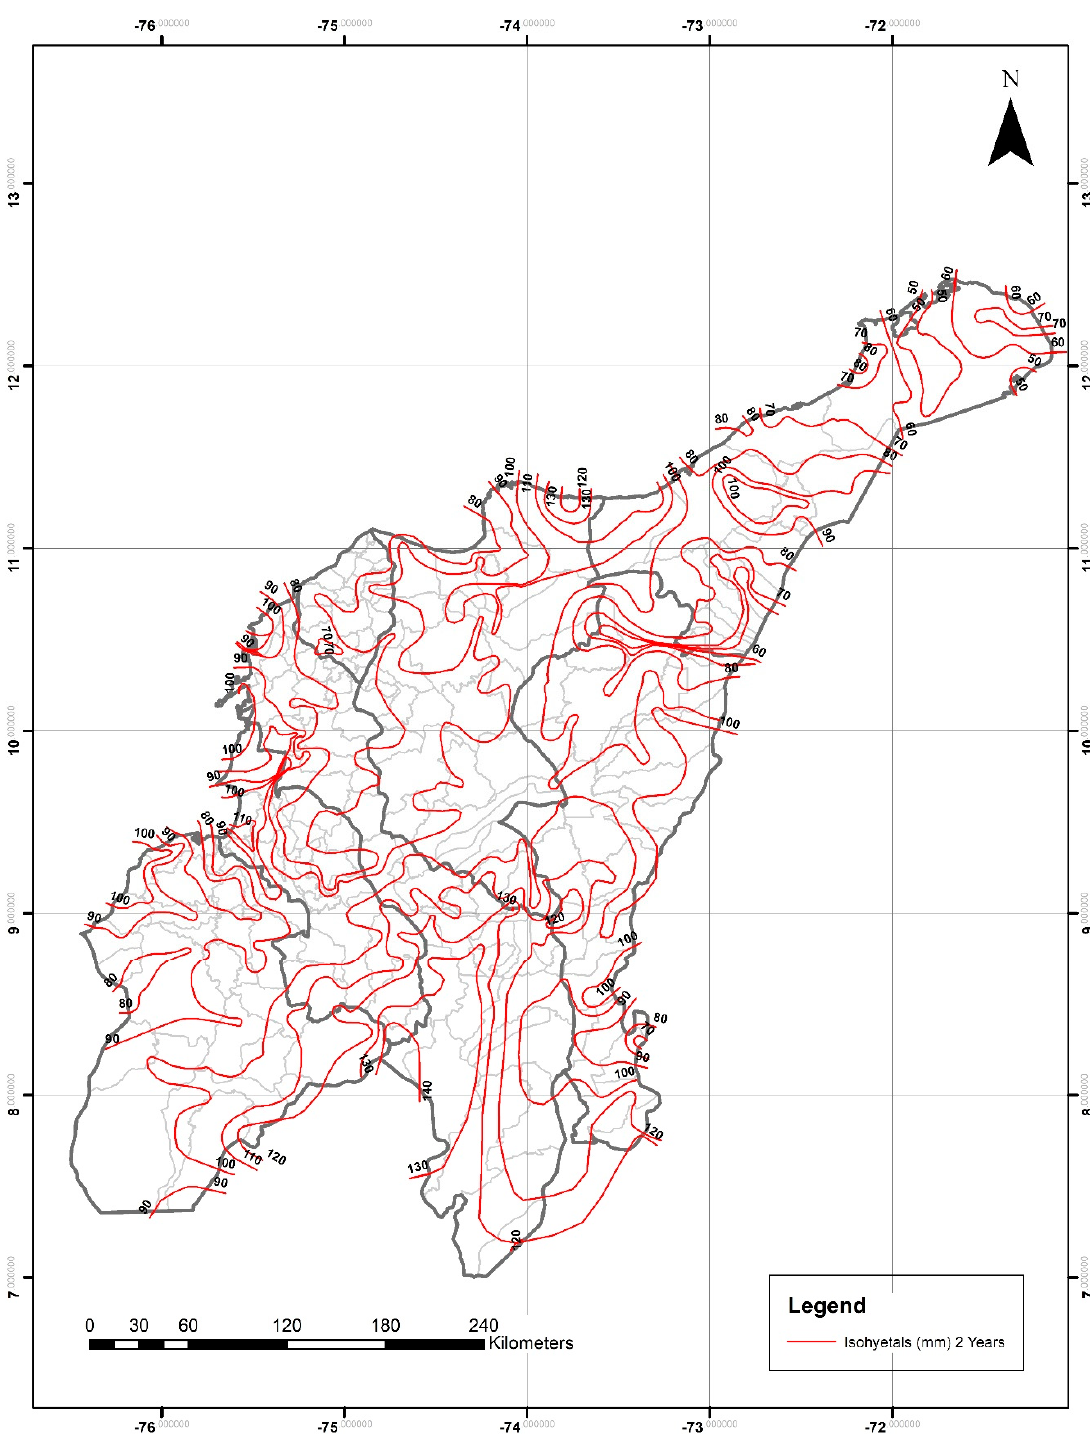
Figure 6. Daily maximum precipitation for a two-year return period (P 24h-max in mm). IDW adjusted method. Light-gray lines are the boundaries of the different municipalities within the departments.